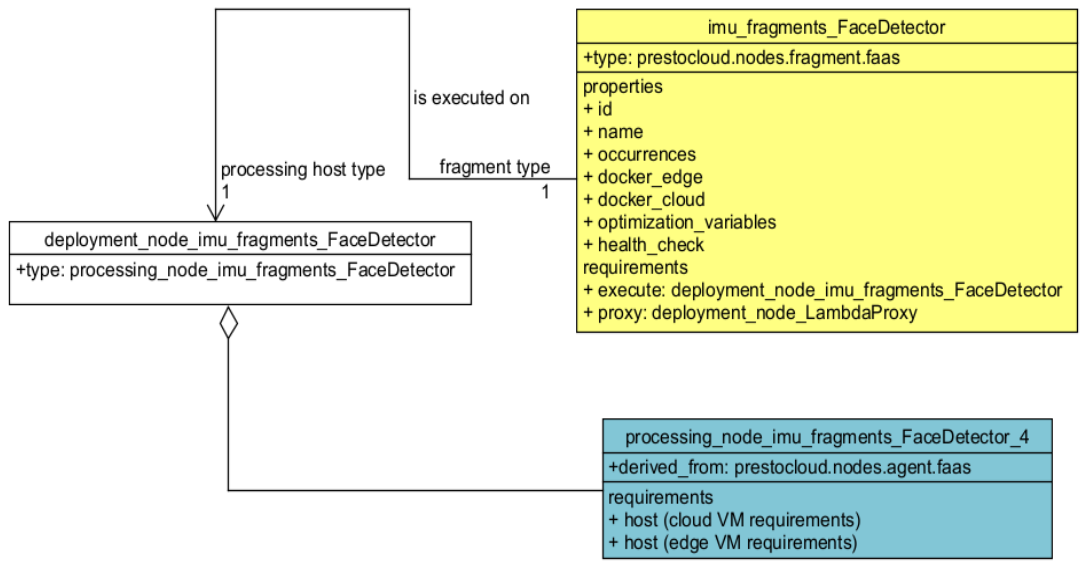
Figure 3. The relationships between fragment, processing, and mapping nodes. An excerpt from the type-level TOSCA showing the sections related to the connection of application fragments (according to our motivation scenario of Section 3) with their respective processing nodes is shown in Listing